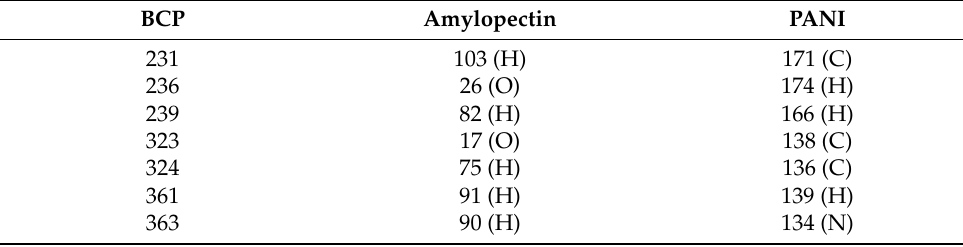
Figure 12. Molecular graph of the optimized PANI–amylopectin complex. Table 13. The topological characteristics at BCP of interaction contacts.